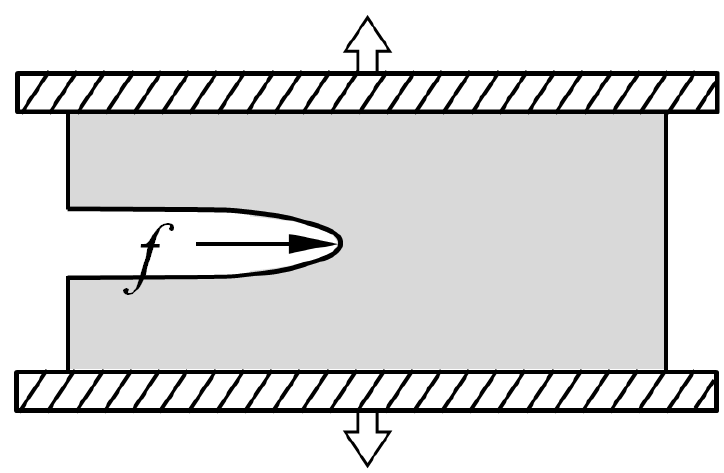
Figure 4. Schematic of cutting loading.